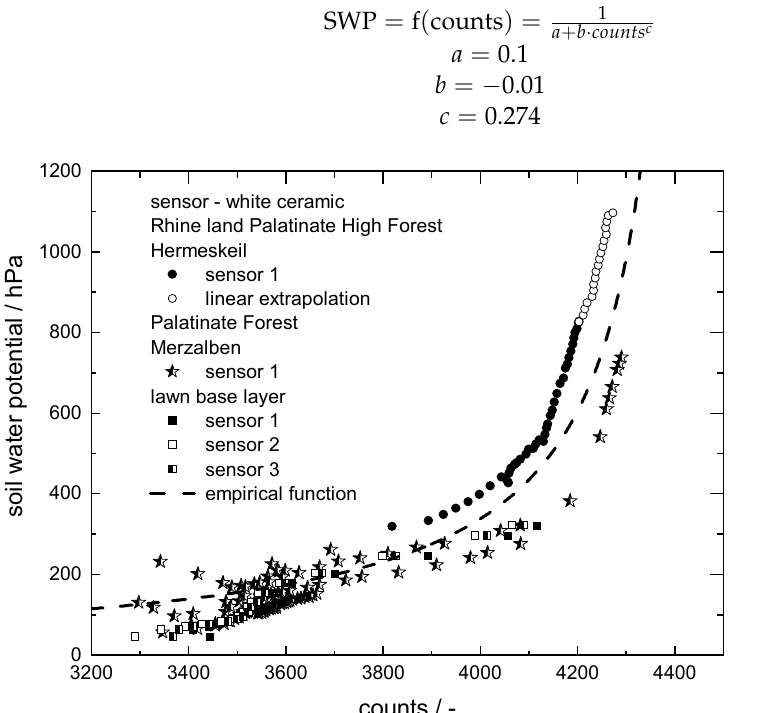
Figure 9. Correlation of soil water potential data (T8) and count values from the sensor with white ceramic discs recorded during drying experiments in model soil lawn base layer [34], as well as forest soil (Palatinate Forest: Merzalben [34] and Rhineland Palatinate High Forest: Hermeskeil).